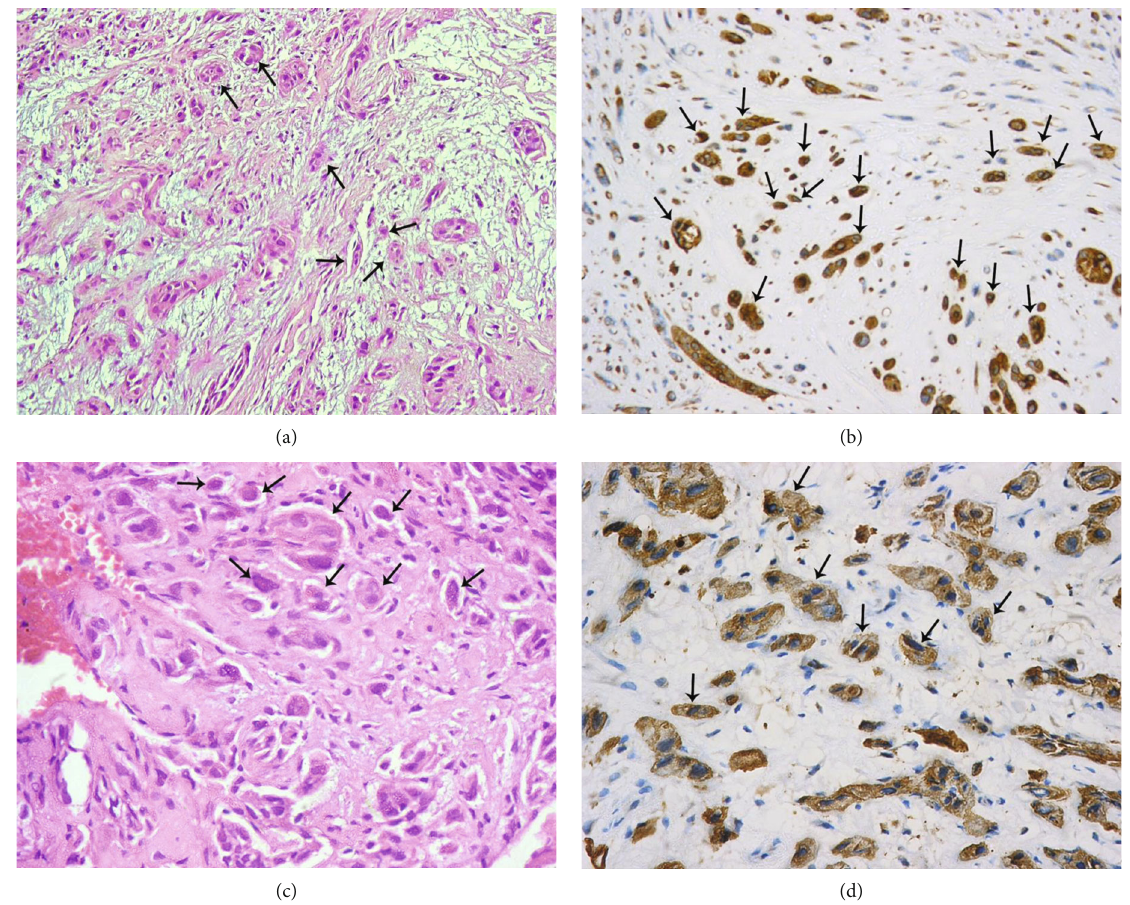
Figure 1: Tumor budding at the invasive front of laryngeal squamous cell carcinoma showing high-intensity tumor budding: (a) by H&E (H&E, × 200), (b) by pancytokeratin (IHC, × 200), (c) by H&E (H&E, × 400), and (d) by pancytokeratin (IHC, × 400). Black arrows are showing examples of the tumor